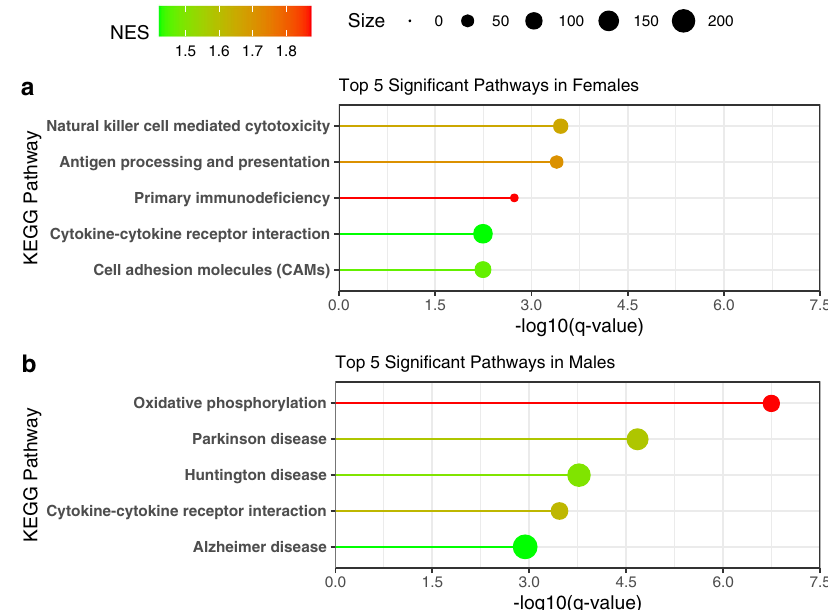
Fig. 6 Immune pathways are disrupted between PD and HC in both sexes. Pathway analysis was conducted using Gene Set Enrichment Analysis (GSEA) and the human Kyoto Encyclopedia of Genes and Genomes (KEGG) pathways in females ( a ) and males ( b ), separately. Genes ranked by the absolute value of the Wald test statistic generated by differential expression analysis between PD and HC were utilized in the analysis. The KEGG pathway name is labeled on the y-axis, the -log10 of the q -value is plotted on the x-axis, the line and dot plotted are colored by the normalized enrichment score (NES) with the highest NES plotted in red and the lowest (from the signi fi cant pathways plotted) in green. The size of the dot in the fi gure represents the number of genes from our input that were in that speci fi c pathway.